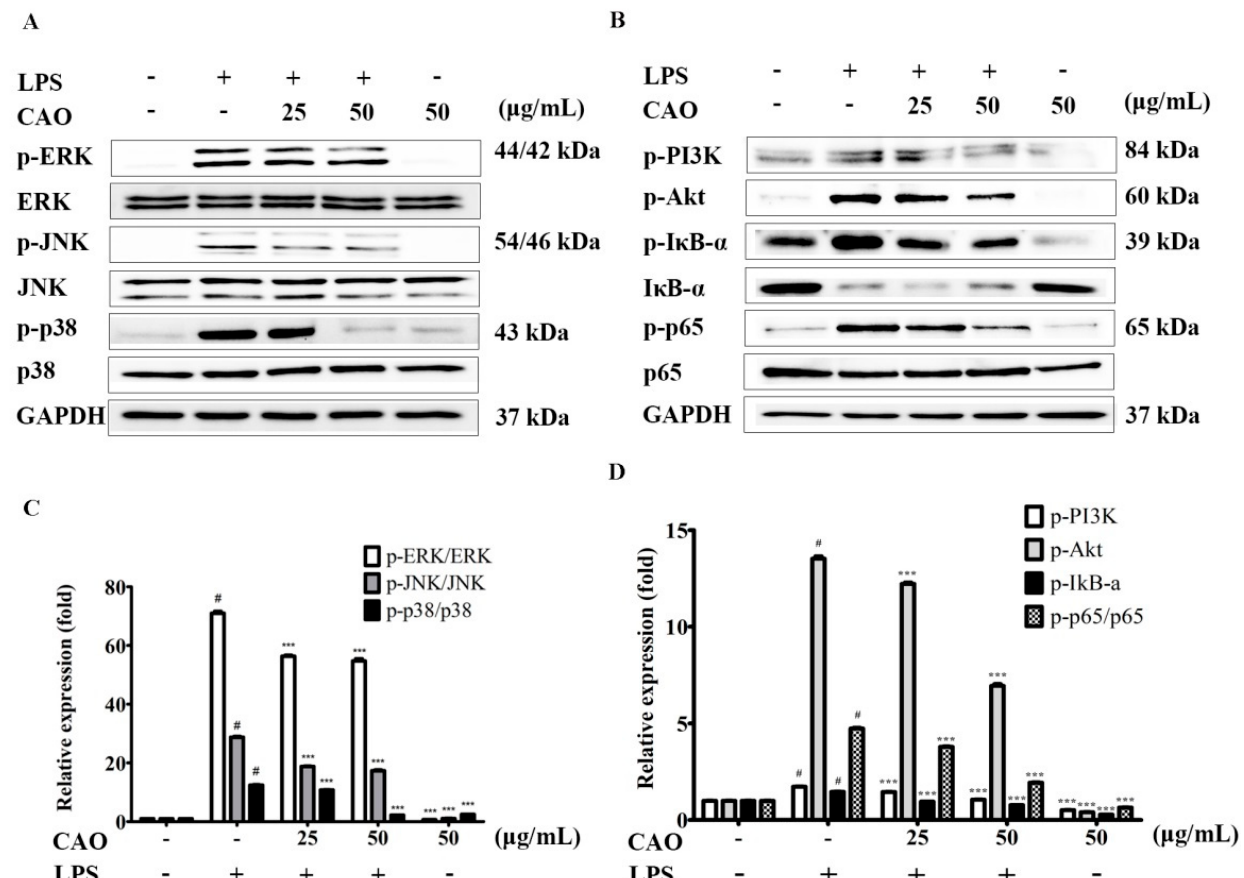
Figure 5. Effect of CAO on MAPK phosphorylations and PI3K/Akt/I κ B/NF- κ B signaling pathways in macrophages. ( A ) The expression of MAPK phosphorylations was subjected to immunoblotting. ( B ) The expression of PI3K/Akt/I κ B/NF- κ B phosphorylations was subjected to immunoblotting. ( C ) The levels of p-ERK, p-JNK, and p-p38 phosphorylations compared to the value of each non-treated group. ( D ) The levels of PI3K, Akt, I κ B- α , and p65 phosphorylations compared to the value of each non-treated group. Data are expressed as the mean ± SD ( n ≥ 3). # p < 0.001 vs. non-treated cells. *** p < 0.001 vs. LPS-treated cells. CAO = callus of A. distichum var. Okhwang 1.